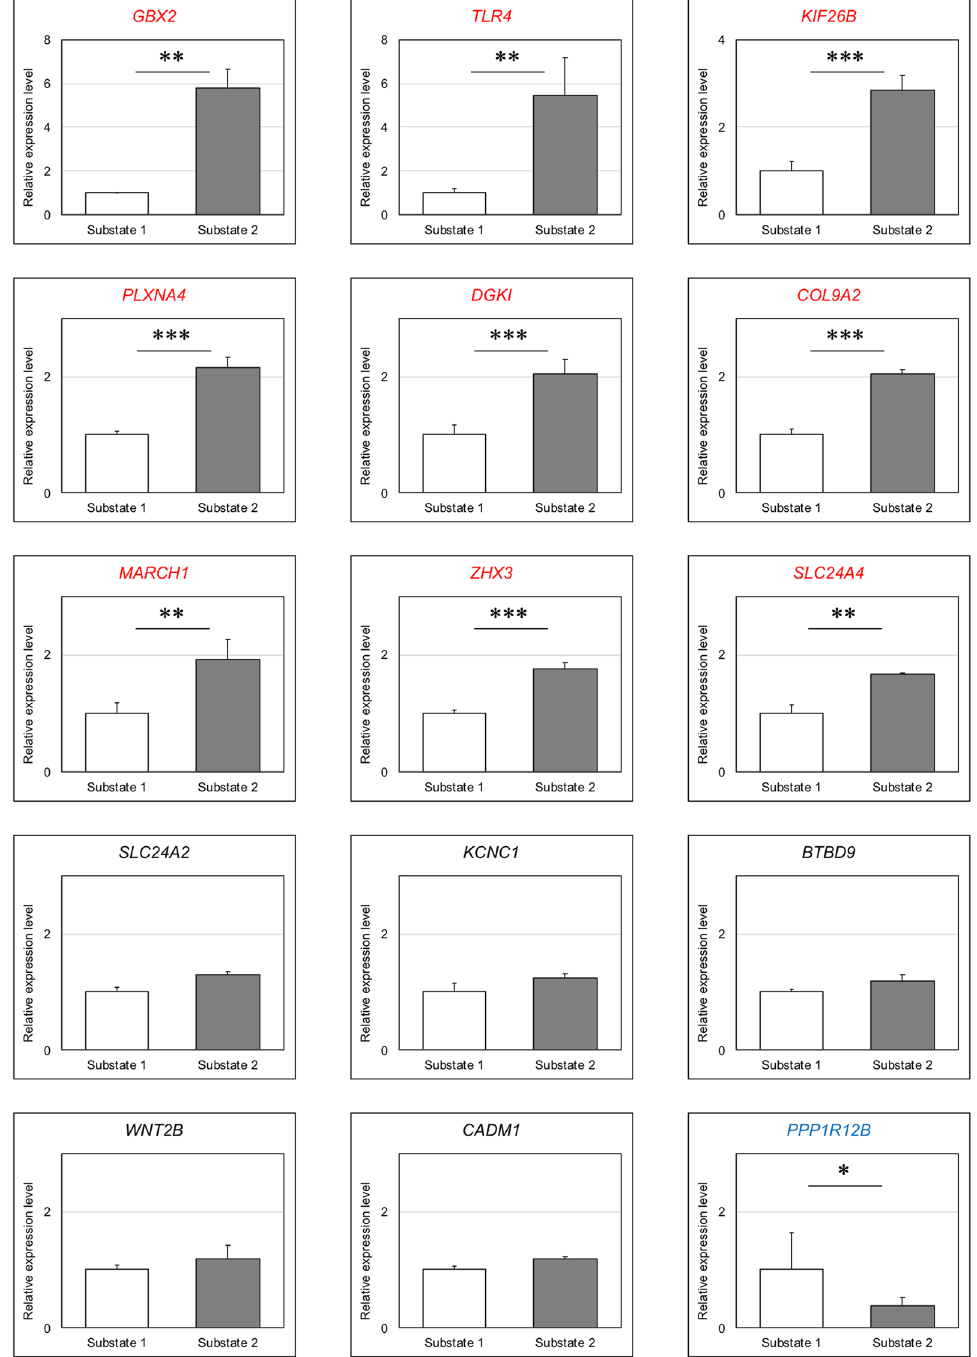
Figure 7. Expression analysis of biomarker candidates for the earliest stages of ectodermal differentiation. One-step real-time RT-PCR analysis of 14 upregulated mRNAs ( BTBD9 , CADM1 , COL9A2 , DGKI , GBX2 , KCNC1 , KIF26B , MARCH1 , PLXNA4 , SLC24A2 , SLC24A4 , TLR4 , WNT2B , and ZHX3 ) and one downregulated mRNA ( PPP1R12B ) in substate 2 of integrated analyses of mRNA and miRNA was performed using RNAs derived from substate 1 and substate 2 cells. The expression of GAPDH was used for normalization. Values are the means ± SDs (n = 3). mRNAs that showed a 1.5-fold difference in expression between substate 1 and substate 2 cells were subjected to analysis of significance using unpaired two-tailed t-tests ( * P < 0.1; ** P < 0.05; *** P < 0.01). Red and blue gene symbols indicate upregulated and downregulated mRNAs,